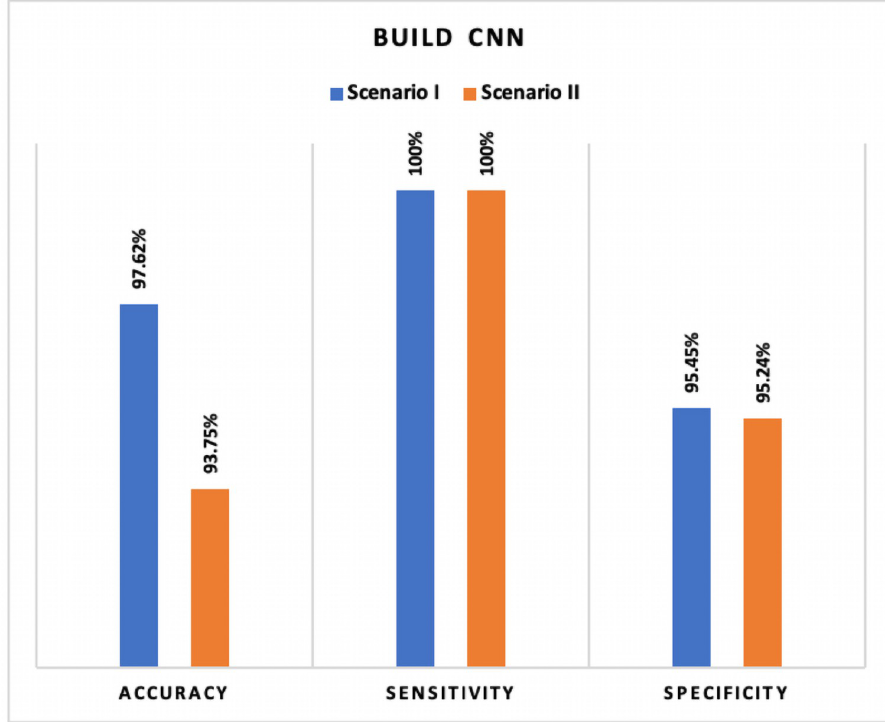
Fig 12. Comparison of accuracy achieved in new CNN: Scenario I and scenario II.